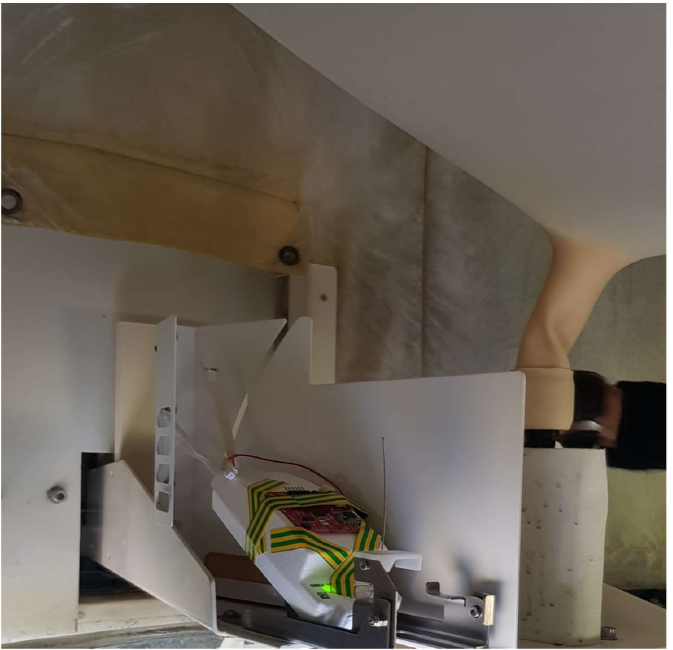
Figure 5. System setup 2 used to determine the transmission ranges reached by the radioprobe system in an open-area environment. Tiny radioprobe attached to the reference atmospheric sounding system.